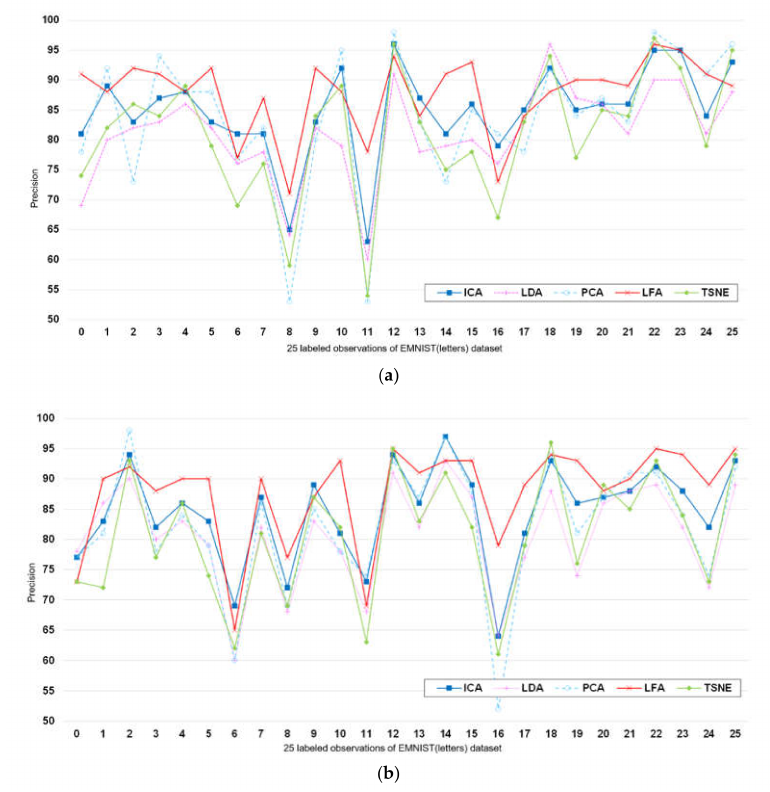
Figure 12. Results of precision and recall evaluation by feature extraction algorithm in k-nearest neighbors (KNN). ( a ) Precision measurement data using KNN. ( b ) Recall measurement data using